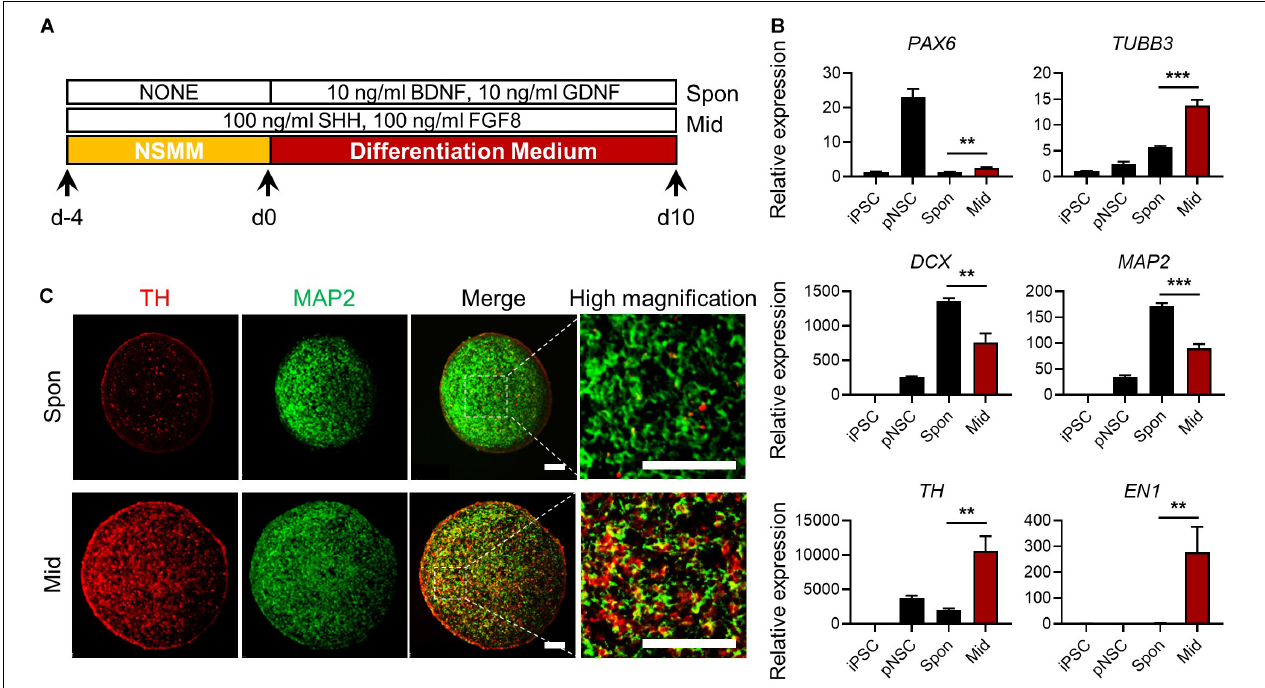
FIGURE 6 | Generation of midbrain-like simplified brain organoids (simBOs). (A) Graphical schematics for midbrain-like simBOs. (B) Quantitative reverse transcription polymerase chain reaction (qRT-PCR) analysis for neural progenitor marker ( PAX6 ), pan-neuronal markers ( TUBB3 , DCX , and MAP2 ) and dopaminergic neuron markers ( TH and EN-1 ) in induced pluripotent stem cells (iPSCs), human primitive neural stem cells (pNSCs), spontaneously differentiated-simBOs (Spon), and midbrain-like simBOs (Mid). Expression value was normalized to those of iPSCs. Data represent mean ± standard error (SE) from three technical replicates. Statistical significance of ** p < 0.01, *** p < 0.001 was calculated by unpaired t -test. (C) Immunofluorescence analysis with pan-neuronal markers (MAP2) and dopaminergic neuronal marker (TH) in Spon-simBOs and Mid-simBOs. Scale bars represent 100 µ m.